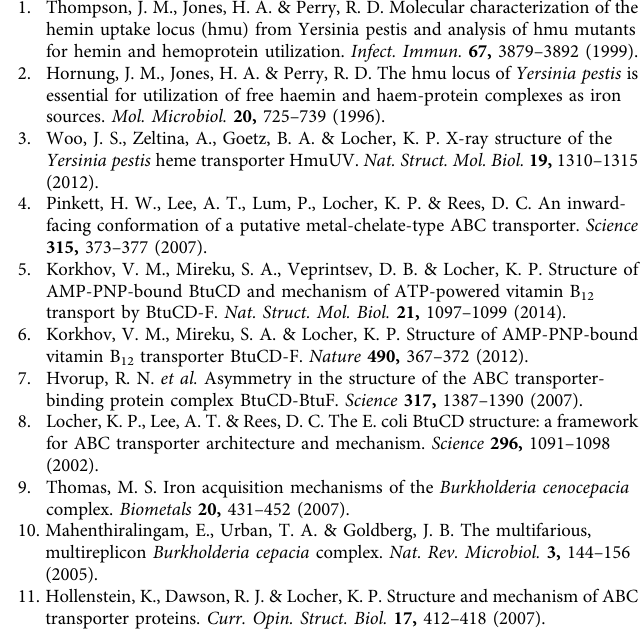
Fig. 3 are: Ec_BtuC, NP_416226; Ec_FecC, NP_418709; Hi_MolB, NP_439622. Data availability . Coordinates and structure factors have been deposited in the Protein Data Bank under accession codes 5B57 (BhuUV) and 5B58 (BhuUV-T). GenBank accession codes used for sequence comparison are presented in the Methods section ‘‘Amino-acids sequences’’. All additional experimental data are available from the corresponding author on reasonable request.